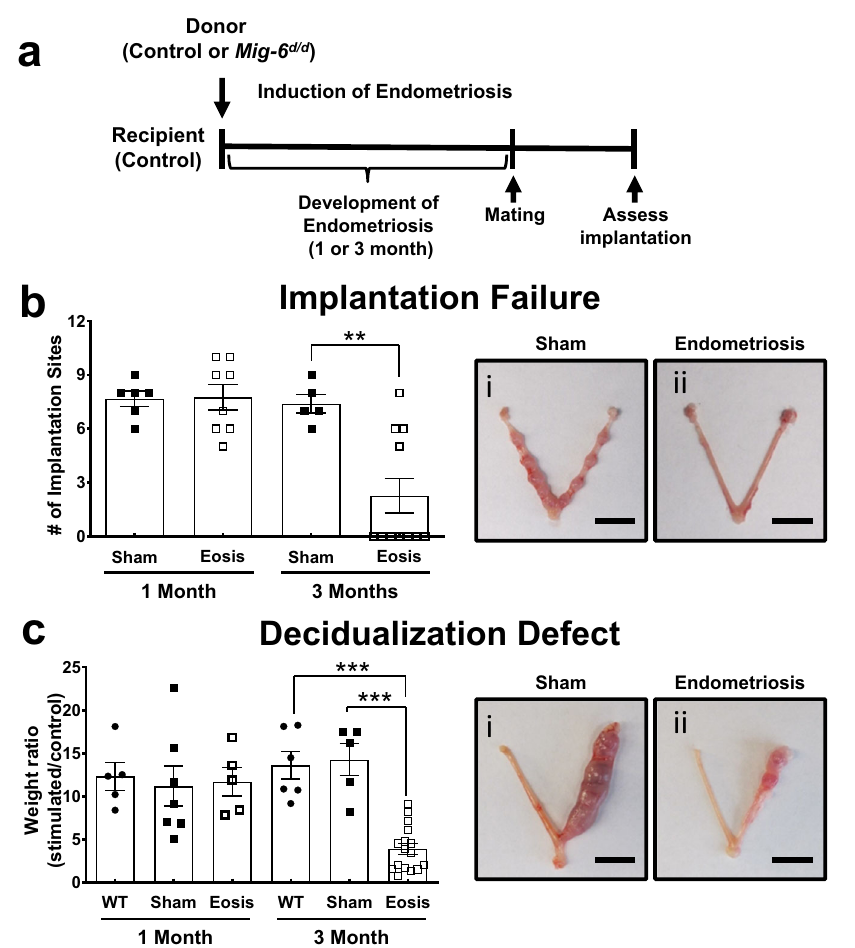
Fig. 2 Defects of implantation and decidualization in mice with endometriosis. a Experimental design to investigate endometriosis-related infertility. b Average number and uterine images of implantation sites at GD 7.5 in mice with endometriosis (Eosis) on 1 and 3 months after endometriosis induction ( n = 6 for sham and n = 8 for endometriosis at 1 month and n = 5 for sham and for n = 11 endometriosis at 3 months). Data are represented as mean ± SEM, ** p = 0.0021 by Ordinary one-way ANOVA test. Scale bars: 1 cm. c Average ratio of stimulated uterine weight to control weight and uterine images of mice with endometriosis after arti fi cially induced decidualization ( n = 5 for wild type, n = 7 for sham, and n = 5 for endometriosis at 1 month and n = 6 for wild type, n = 5 for sham, and n = 16 for endometriosis at 3 months). Data are represented as mean ± SEM, *** p = 0.0001 by Ordinary one-way ANOVA test. Scale bars: 1 cm. Three independent experiments were performed for ( b ) and ( c ) with similar results. Source data are provided in the Source Data fi